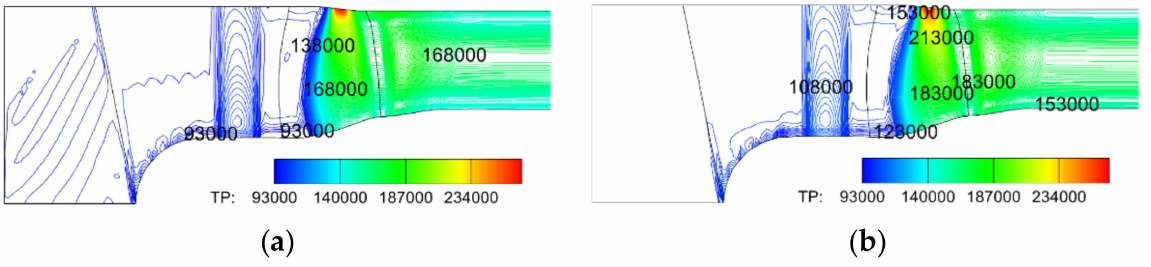
Figure 21. Isoline of the total pressure for 11D: ( a ) distorted; ( b ) clean.